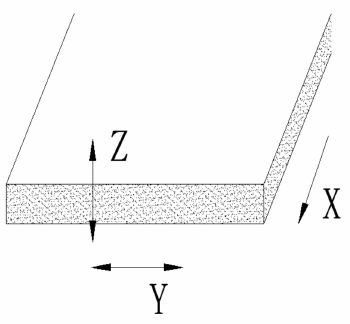
Figure 1. Schematic image of short-fiber orientation